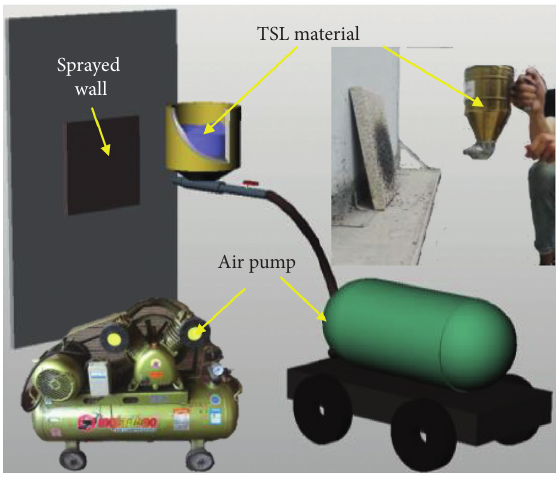
Figure 3: Jet experimental